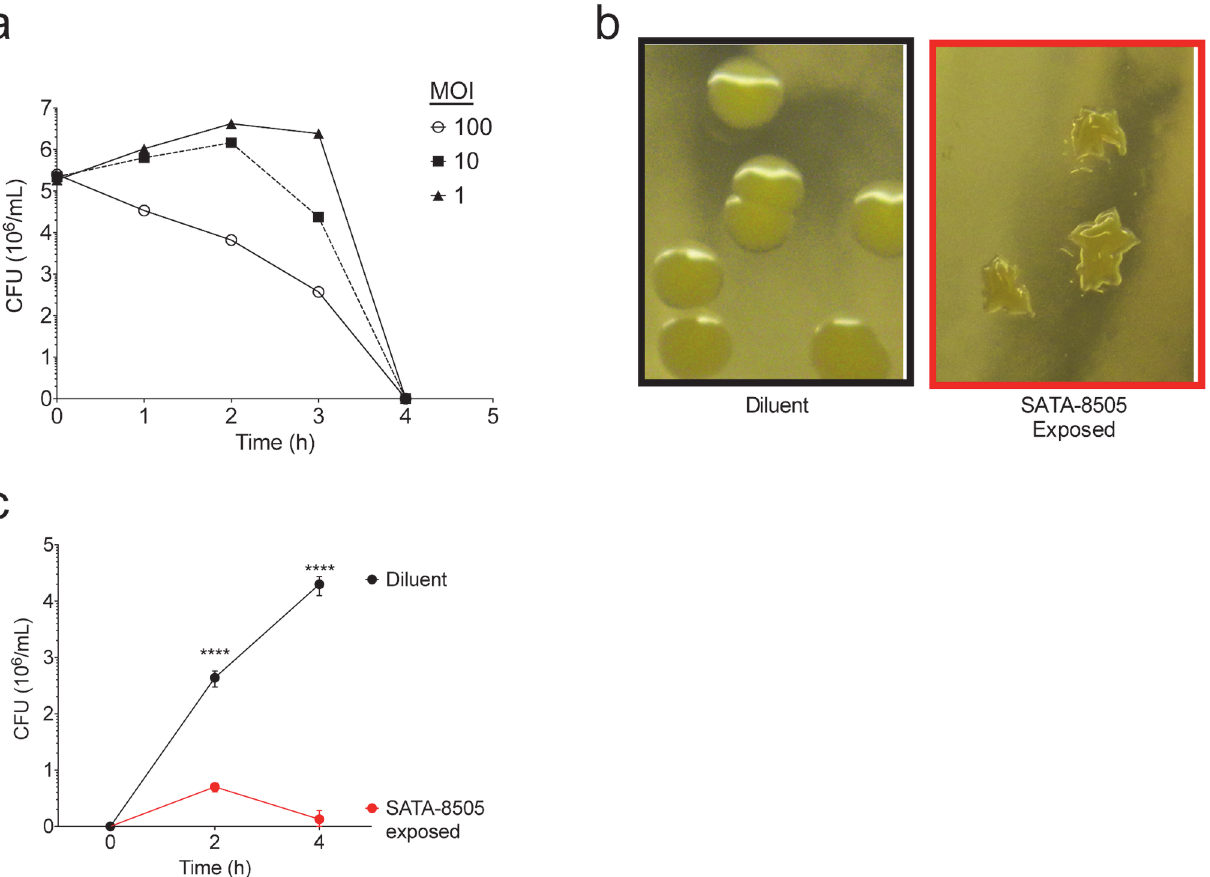
Fig 1. SATA 8505 Effectively Kills USA 300 and Reduces its Viability in vitro. (a) Average colony forming unit (CFU) counts for USA300 cultured with SATA-8505 for up to four hours at ratios of S . aureus :Phage of 1:1, 1:10, or 1:100 (MOI 1, 10, 100 respectively). (b) Images of surviving colony morphology of USA300 grown in TSB after exposure to BHI (diluent) or SATA-8505. (c) Regrowth of surviving colonies pictured in panel b, S . aureus grown in TSB after prior exposure to BHI (diluent) or SATA-8505 run in triplicate culture. Data shown are representative of 3 or more independent experiments and displayed as mean + s.e.m. **** = p <